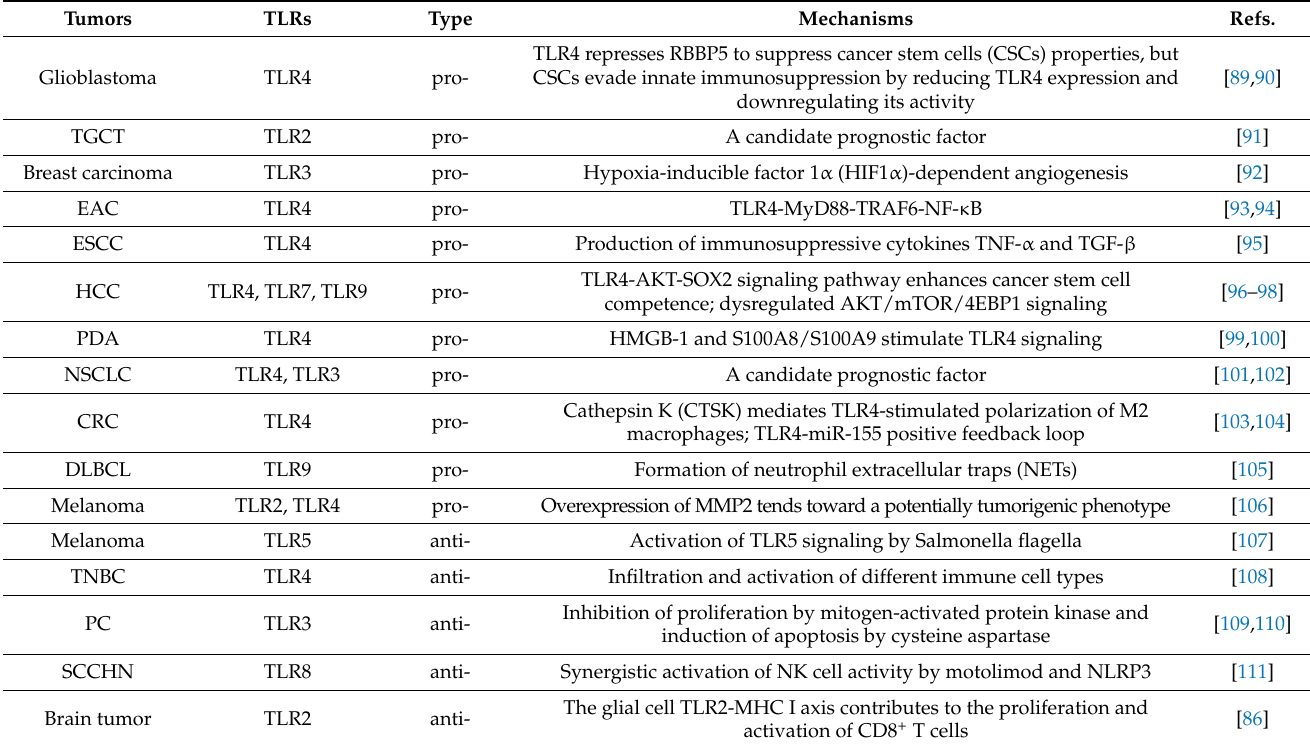
Table 1. Different types of TLRs are involved in tumor progression or inhibition through different